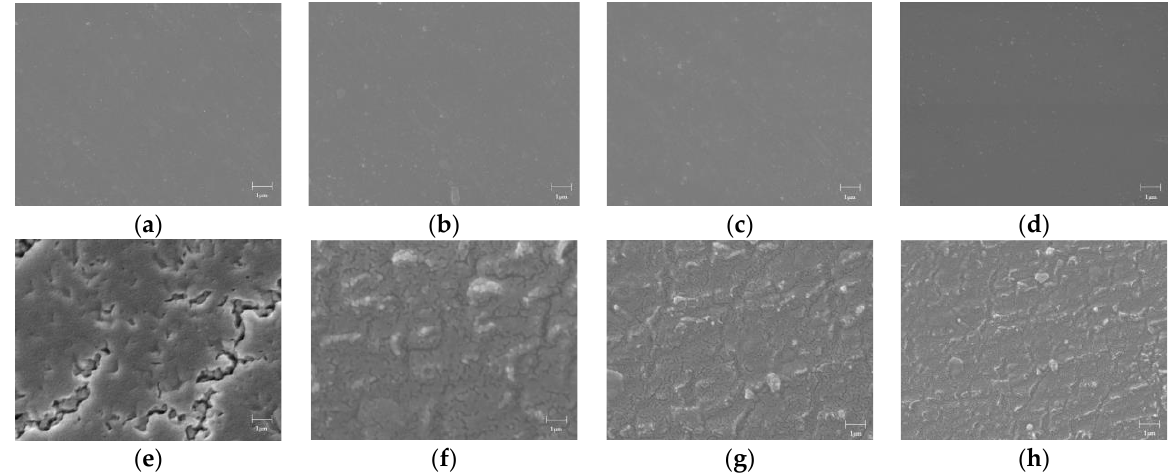
Figure 11. SEM micrographs of films. ( a ) PP0 before flashover; ( b ) PP1 before flashover; ( c ) PP3 before flashover; ( d ) PP5 before flashover; ( e ) PP0 after flashover; ( f ) PP1 after flashover; ( g ) PP3 after flashover; ( h ) PP5 after flashover.